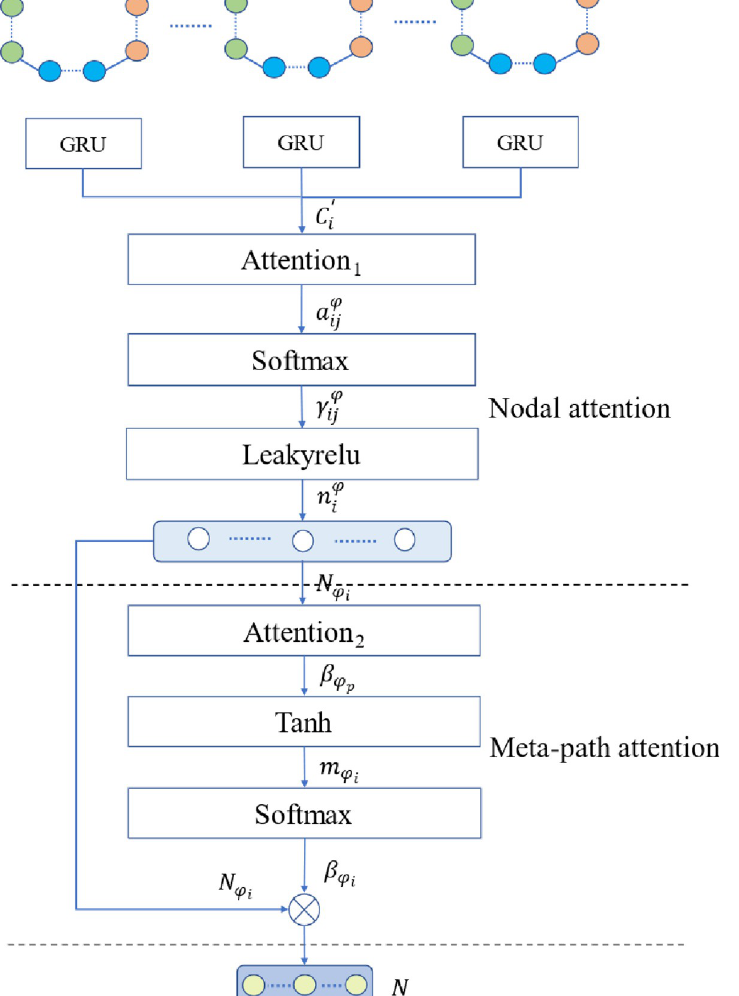
Fig 5. Overall flow chart of the attention